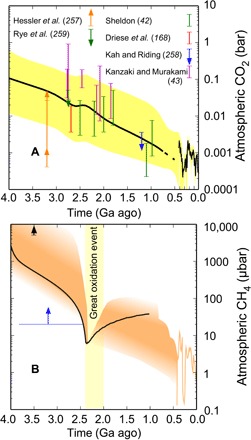
History of CO2 and a CH4 schematic since the Archean.(A) The black line is median CO2 from a carbonate-silicate climate model, and yellow shading indicates its 95% confidence interval (34); this curve merges with a fit to CO2 proxy estimates for 0.42 Ga ago to present from (256). Various Precambrian pCO2 proxy estimates are shown (42, 43, 168, 257–259). (B) A very schematic history of CH4. Constraints include a lower limit (blue) required for Archean S-MIF (44) and a tentative lower limit of ~3.5 Ga ago from a preliminary interpretation of xenon isotopes (black) (187). The black curve is from a biogeochemical box model coupled to photochemistry (121). Orange shading is schematic but consistent with possible biological CH4 fluxes into atmospheres of rising O2 levels at the GOE and in the Neoproterozoic. Note that the suggestion that moderately high levels of methane may have contributed to greenhouse warming in the Proterozoic (260, 261) has been disputed (262, 263) and may depend on fluxes from sources on land (264). The curve for ~0.4 Ga ago to present is from (265).